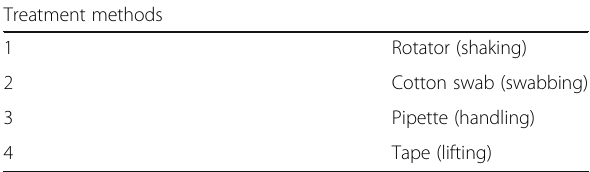
Table 4 Four treatment methods Treatment methods